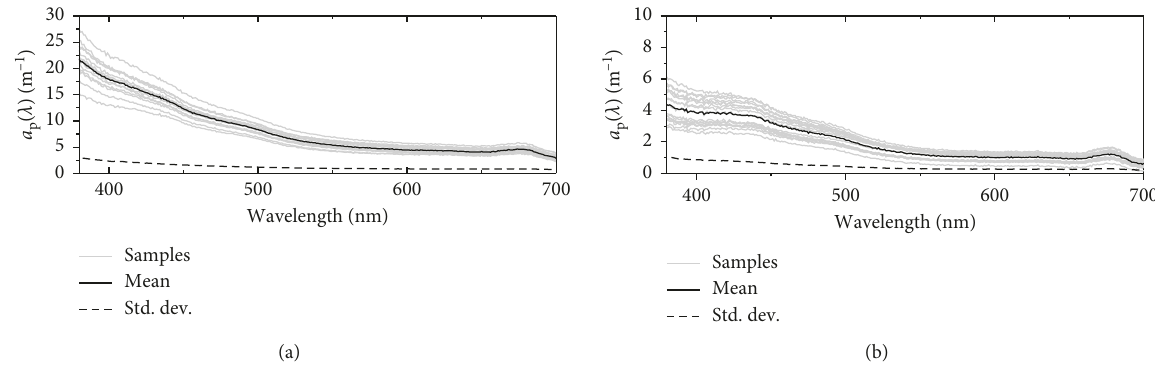
Figure 2: Total suspended particulate absorption spectra in Poyang Lake in July (a) and September (b).